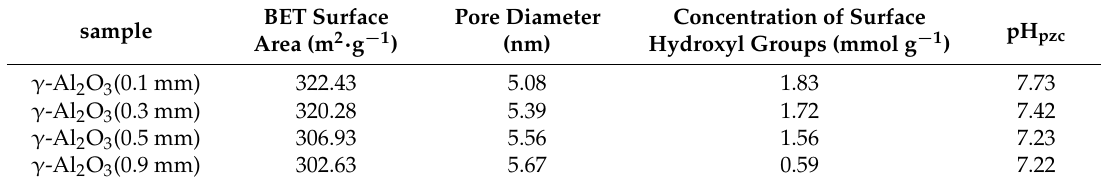
Table 1. Refined physicochemical parameters for the commercial γ -alumina with different sizes.